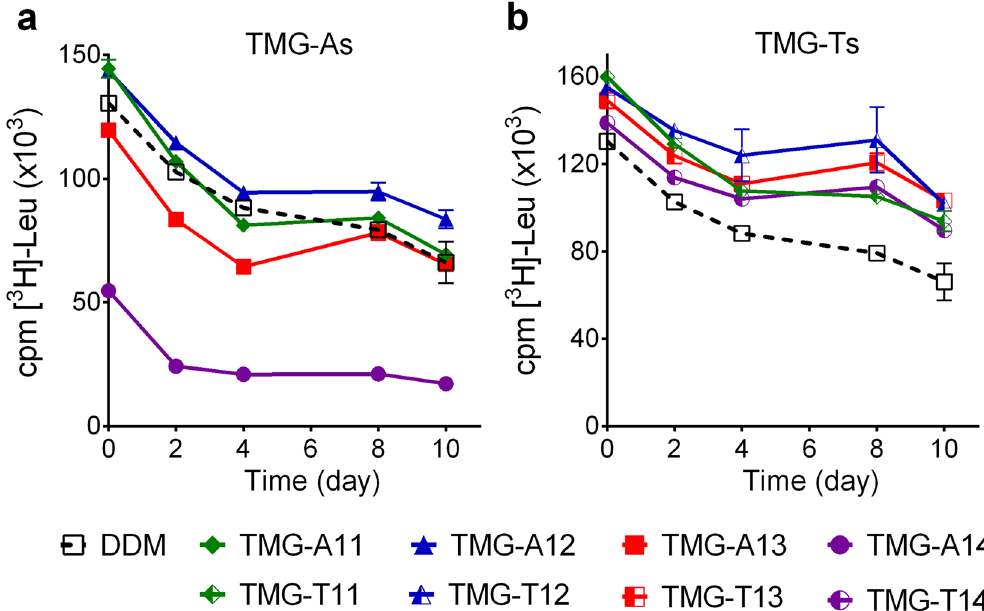
Figure 4. Long-term activity of LeuT solubilized in the TMG-As (TMG-A11, TMG-A12, TMG-A13, or TMG- A14) ( a ) or TMG-Ts (TMG-T11, TMG-T12, TMG-T13, or TMG-T14) ( b ). Detergent efficacy of the TMGs was compared with DDM, a gold standard conventional detergent. LeuT stability was assessed by measuring the ability to bind a radiolabeled leucine ([ 3 H]-Leu) via scintillation proximity assay (SPA) and monitored at regular intervals over the course of a 10-day incubation at room temperature. The results are expressed as specific binding of [ 3 H]-Leu (mean ± SEM, n = 2). All detergents were used at CMC + 0.04